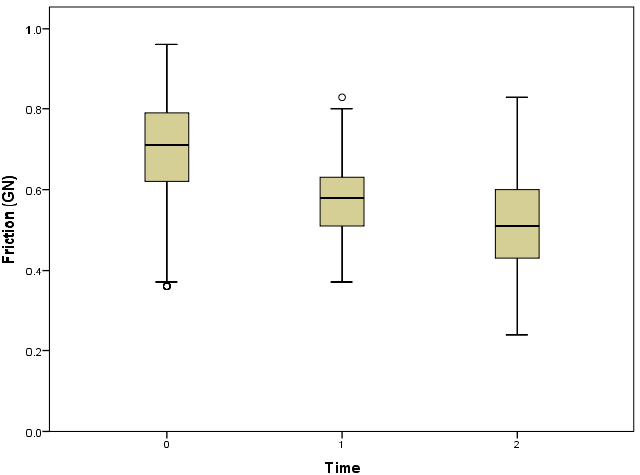
Figure 3. Friction box plot for each time period under study.